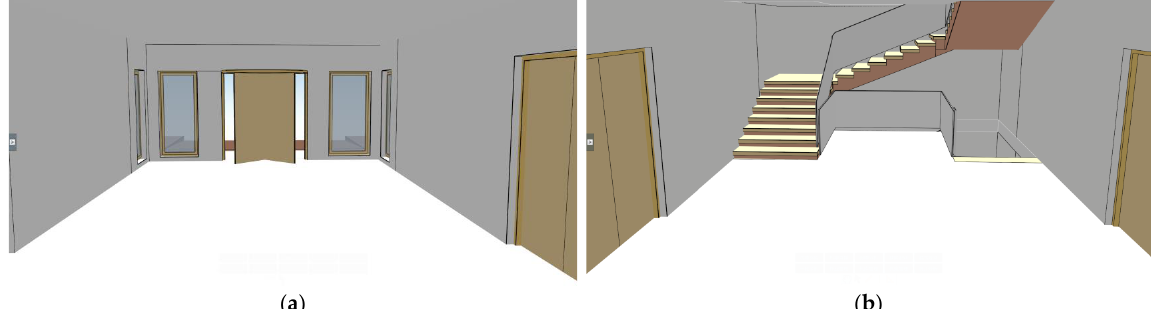
Figure 16. Model output based on the Liu et al. (2016) strategy. ( a ) Visible and ( b ) invisible outdoor scenes.